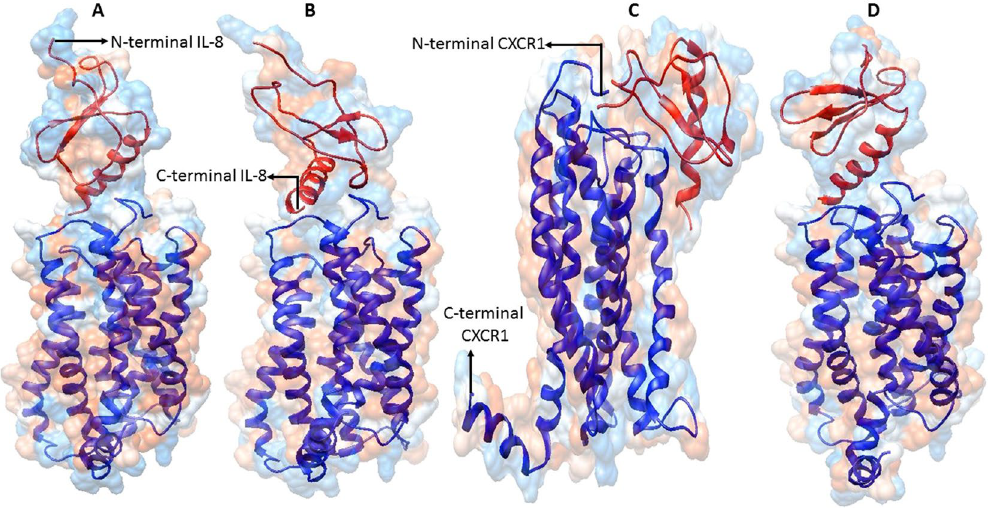
Figure 7. The representative docking poses of IL-8 wild type (IL-8 WT) (Panel A) and mutant proteins (IL-8 E31A & IL-8 E31K) (Panel B–D) onto its receptor IL-8R1 (PDB id: 2LNL). The IL-8 WT and mutants proteins are red colored and the receptor CXCR1 is blue colored. The N- and C-terminal ends of both IL-8 WT/mutants and CXCR1 are also